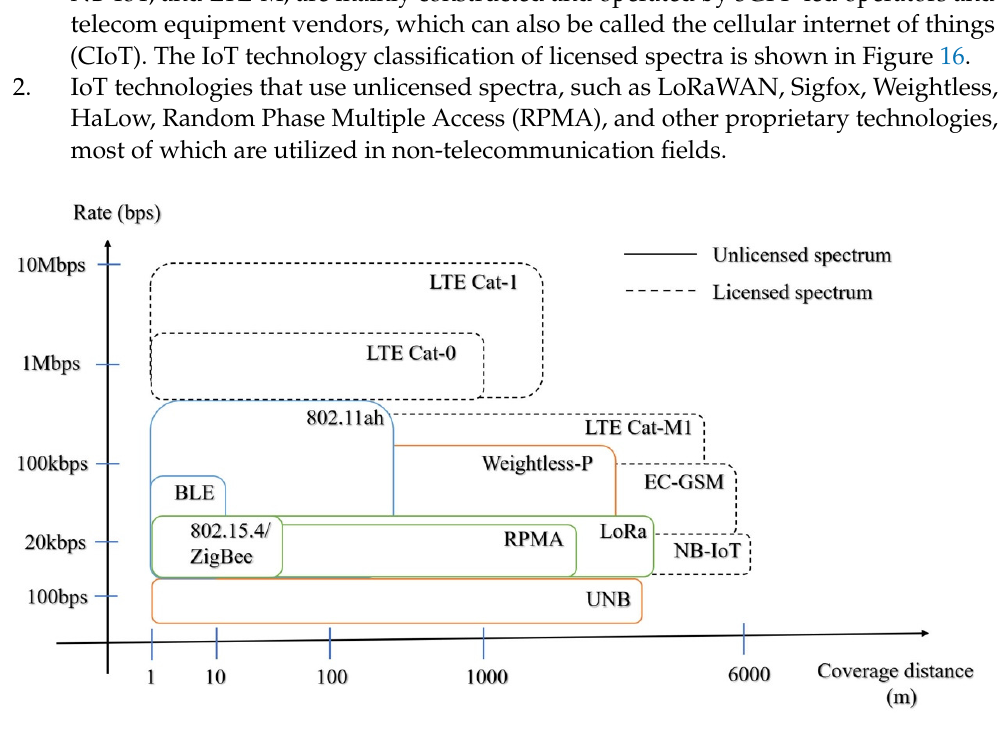
Figure 15. IoT Technology Classification.